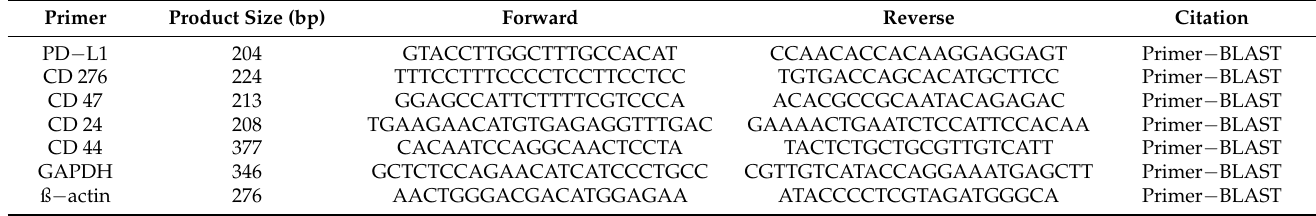
Table A2. Primer